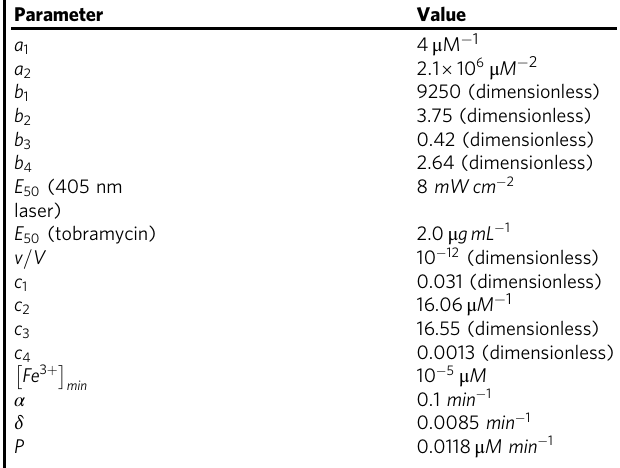
Table 1 Parameters used for the theoretical modeling